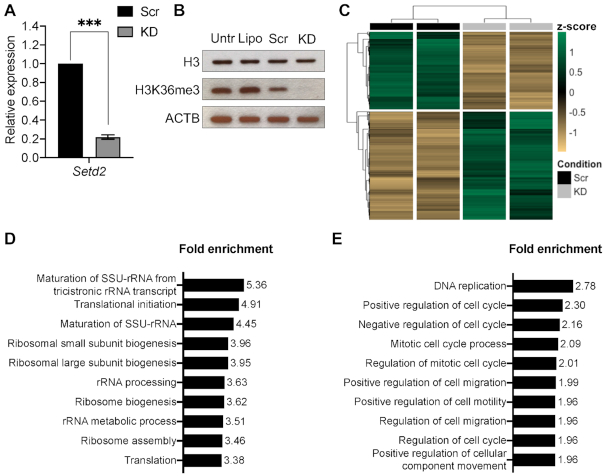
(A) Setd2 mRNA levels assessed by RT-qPCR 48 h post transfection. All data are normalised to Ct values for Actb. Data are given as mean 2−ΔΔCt values ± SEM of three independent experiments. ***P < 0.001 compared with Scrambled group by unpaired t-test. Scr, scrambled control; KD, knockdown. (B) Western blot of whole cell lysate showing effective depletion of H3K36me3 upon knockdown of Setd2. Total histone H3 levels are unaffected. ACTB was used as a loading control. Untr, untreated cells; Lipo, transfection vehicle only; Scr, scrambled control; KD, knockdown. (C) RNA-seq heatmap of significant differentially expressed transcripts 48 h post transfection. Values are given as row-wise standard-normalised fragments per kilobase of transcript per million mapped reads (z-score). Scr, scrambled control; KD, knockdown. (D) Top ten upregulated biological processes determined by GO analysis (PANTHER). See Supplementary Table S6 for a complete list of GO ID terms. (E) Top ten downregulated biological processes determined by GO analysis (PANTHER). See Supplementary Table S7 for a complete list of GO ID terms.